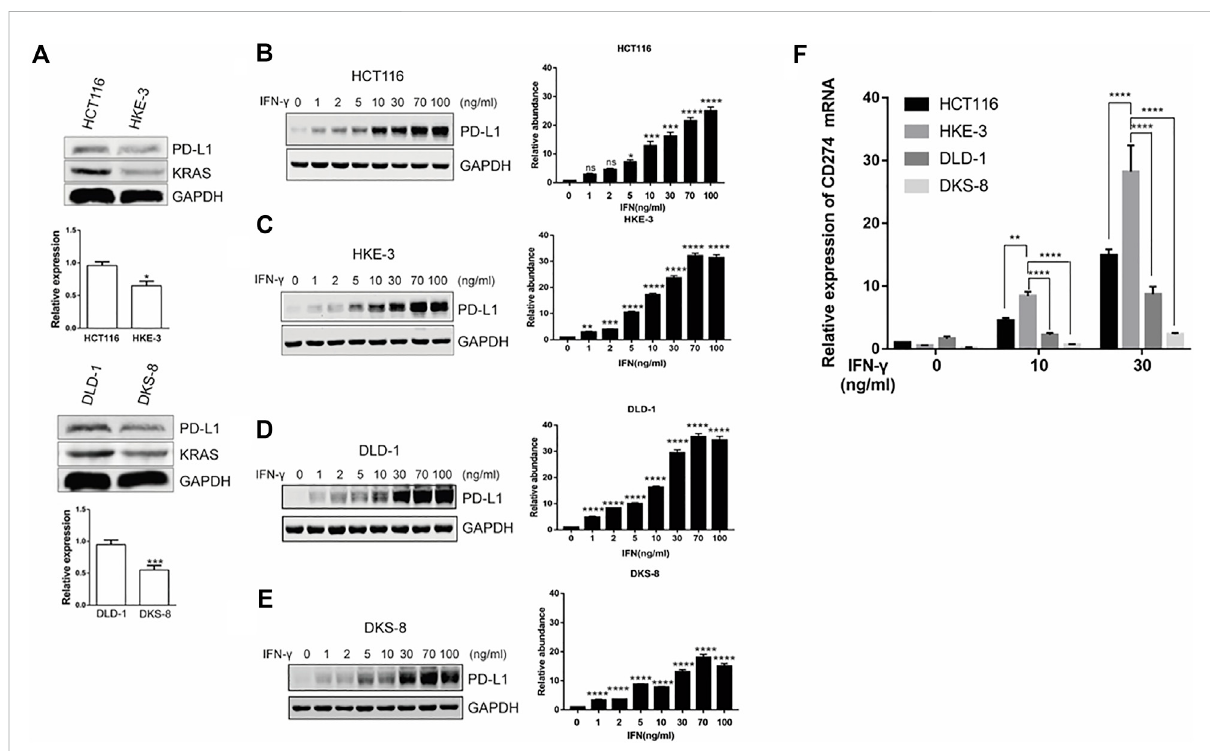
FIGURE 2 KRAScouldaffectinducedPD-L1expressioninCRCcells(i.e.,HCT116andDLD-1:mutantKRAScell;HKE-3andDKS-8:wild-typeKRAScell). (A) PD-L1 mRNA and protein in CRC cells were detected using Western blot and RT-PCR analyses. * p < 0.05 vs HCT116; *** p < 0.001 vs. DLD-1 (B – E) . IFN- γ inducedPD-L1 protein expression inboth wild-type KRAS (i.e., HKE-3 and DKS-8) and mutantKRAS cells (i.e., HCT116 and DLD-1) as detected by Western blots. * p < 0.05, ** p < 0.01, *** p < 0.001, and **** p < 0.0001 vs. IFN- γ 0 ng/ml (F) Higher PD-L1 (CD274) mRNA expression was induced by IFN- γ in wild-type KRAS cells (i.e., HKE-3) among the four CRC cell lines. The four CRC cell lines were treated with different concentrations(i.e.,0,10,and30 ng/ml)ofhumanrecombinantIFN- γ .After48 h,cellswerecollected,andthemRNAexpressionwasdeterminedby RT-PCR. * p < 0.05, ** p < 0.01, and **** p < 0.0001 vs. no IFN- γ